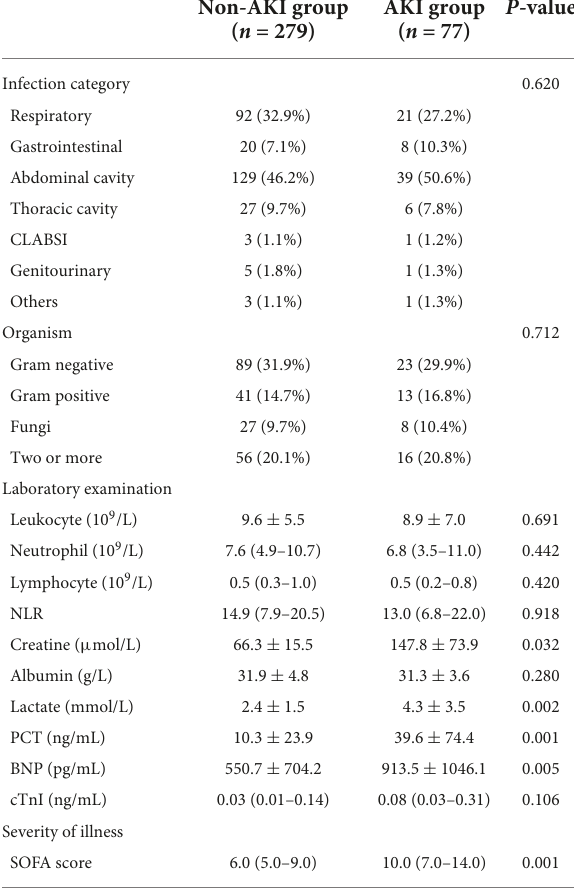
TABLE 2 Infectious data and laboratory data of the two groups after ICU admission.